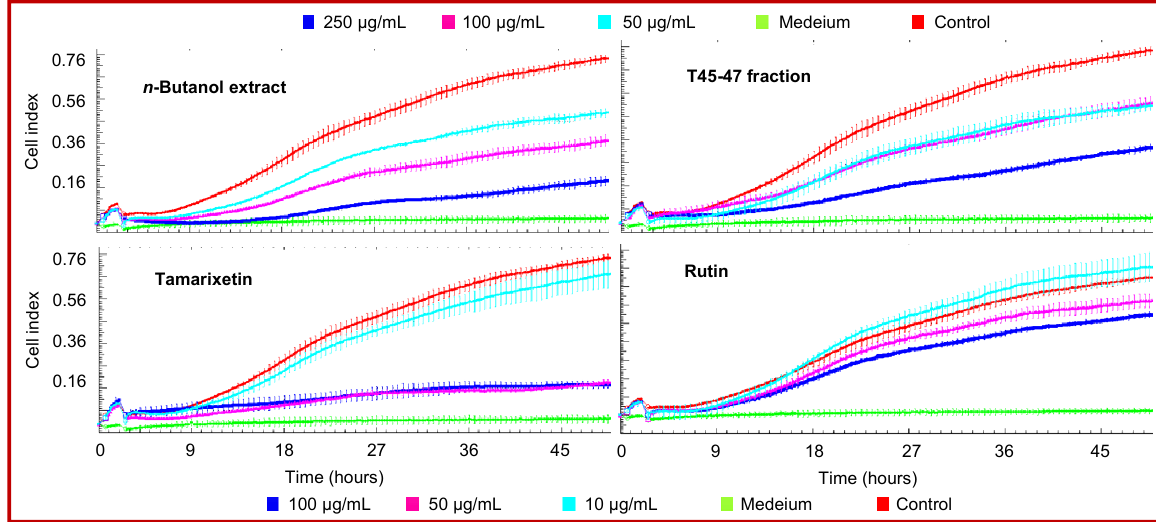
Figure 3: Anti-proliferative effect of the n-butanol extract, fractions T45-47, tamarixetin and rutin